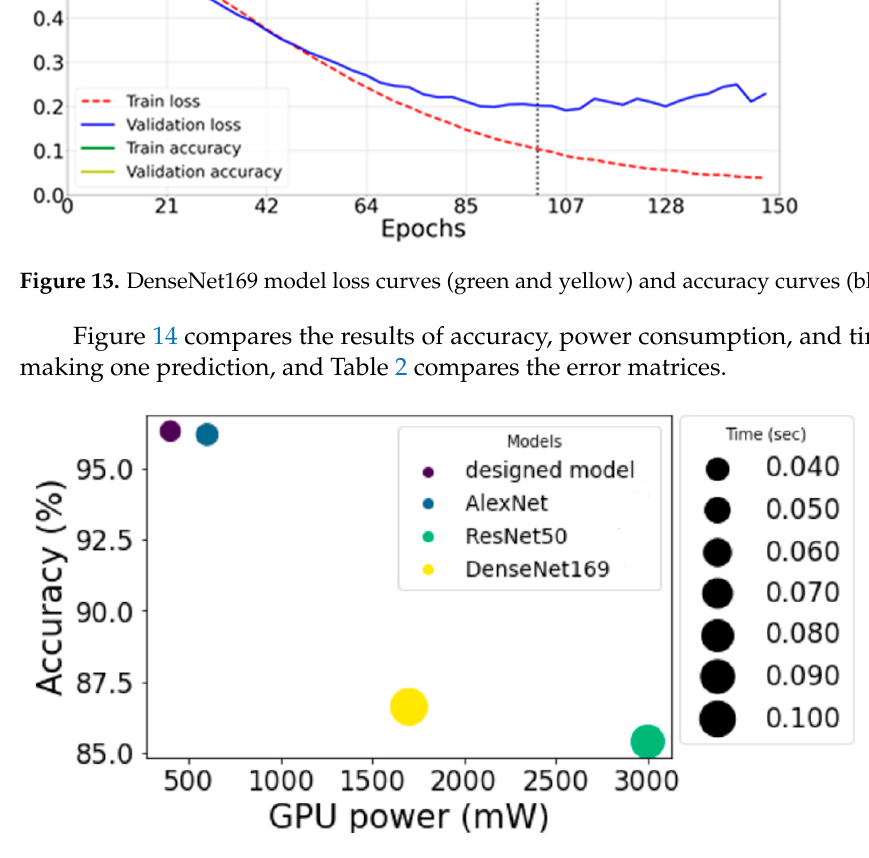
Figure 14. Comparison of the results of the studied and designed models. Table 2. Confusion matrices of the studied models.